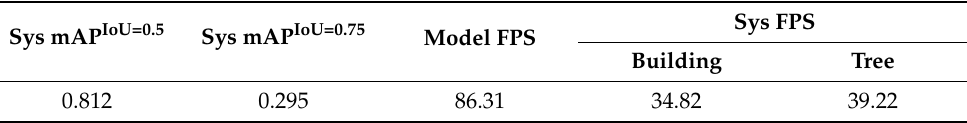
Table 8. ASTIL fast processing system performance evaluation. Sys mAP